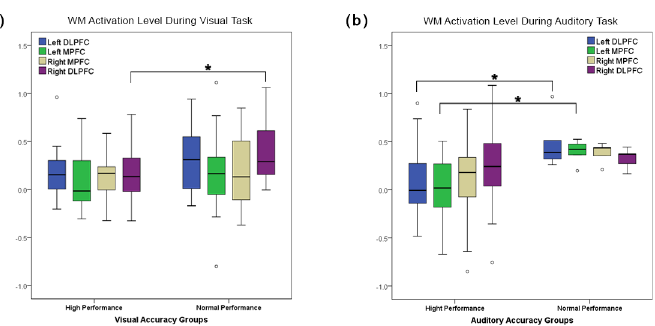
Fig 4. Differences in activation between high performance (HP) and normal performance (NP) groups. Both auditory and visual NP groups showed higher activation in PFC compared to their high-performance cohorts in right DLPFC during visual (a) and left DLPFC and MPFC during auditory (b) tasks.